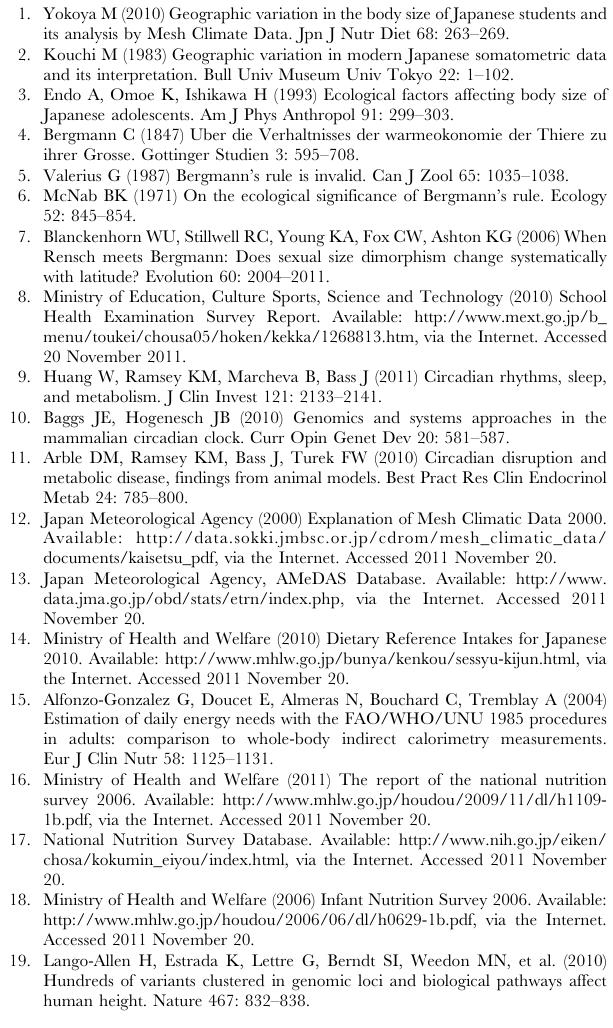
Table S3 Population-weighted averaged climatic values derived from mesh climatic data in each